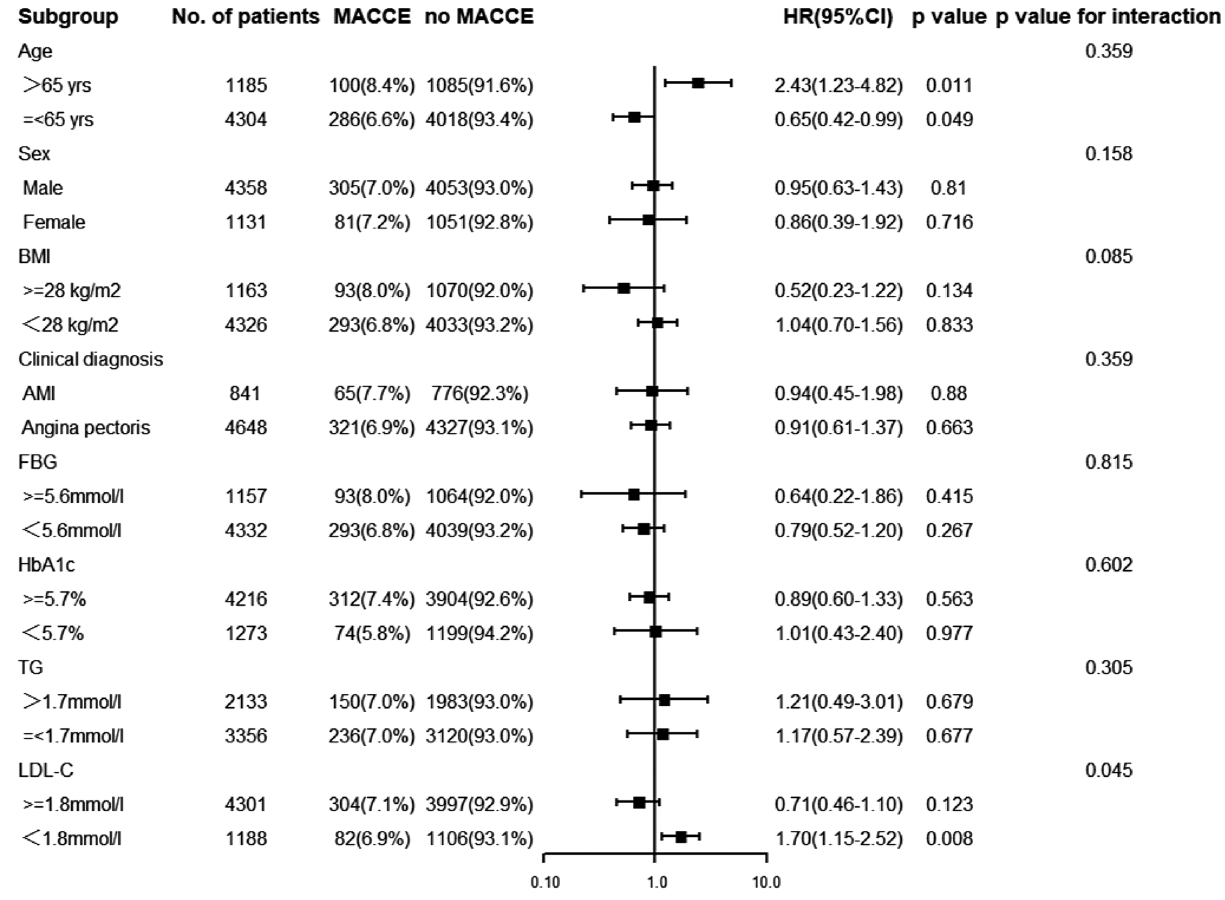
FIGURE 3 | Subgroup analysis for the effect of the TyG index on the risk of the primary endpoint. The analysis was performed by adjusting for Model (age, gender, dyslipidemia, previous history of stroke, MI, PCI, and CABG, Multivessel disease, CTO disease, ISR disease, SYNTAX score, numbers of stent, LVEF, FBG, HbA1c and hs-CRP). BMI, body mass index; AMI, acute myocardial infarction; FBG, fasting blood glucose; HbA1c, glycosylated hemoglobin A1c; TG, triglyceride; LDL-C, low-density lipoprotein cholesterol; HR, hazard ratio; CI, con fi dence